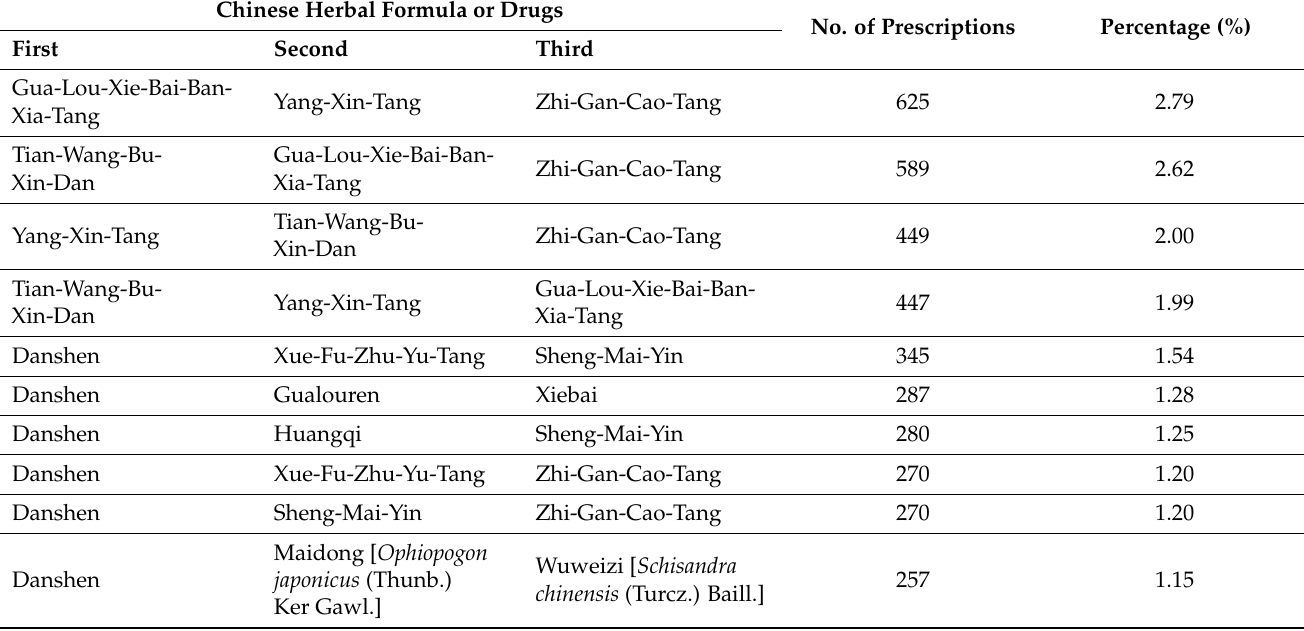
Table 7. The most common three-drug combinations of TCM in a single prescription for IHD (total prescription number, n =